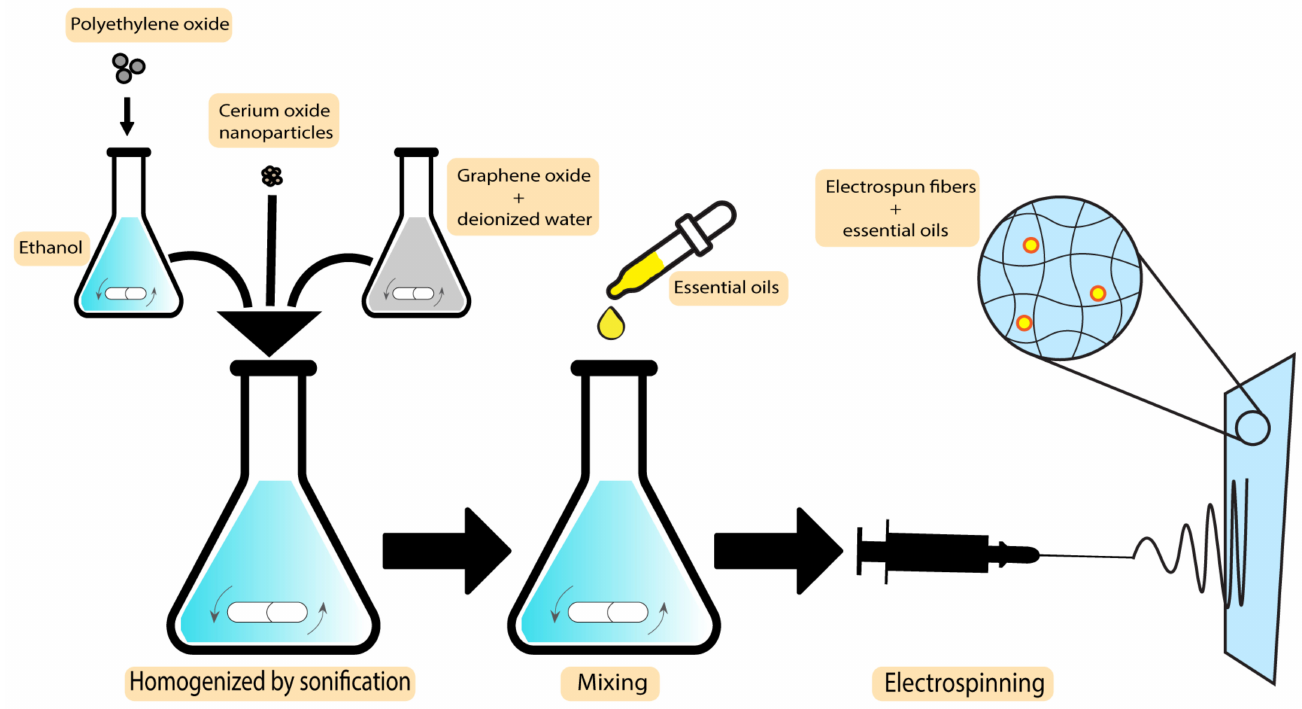
Figure 7. Preparation technique of CeO2-PM oil-PEO/GO nanofibrous